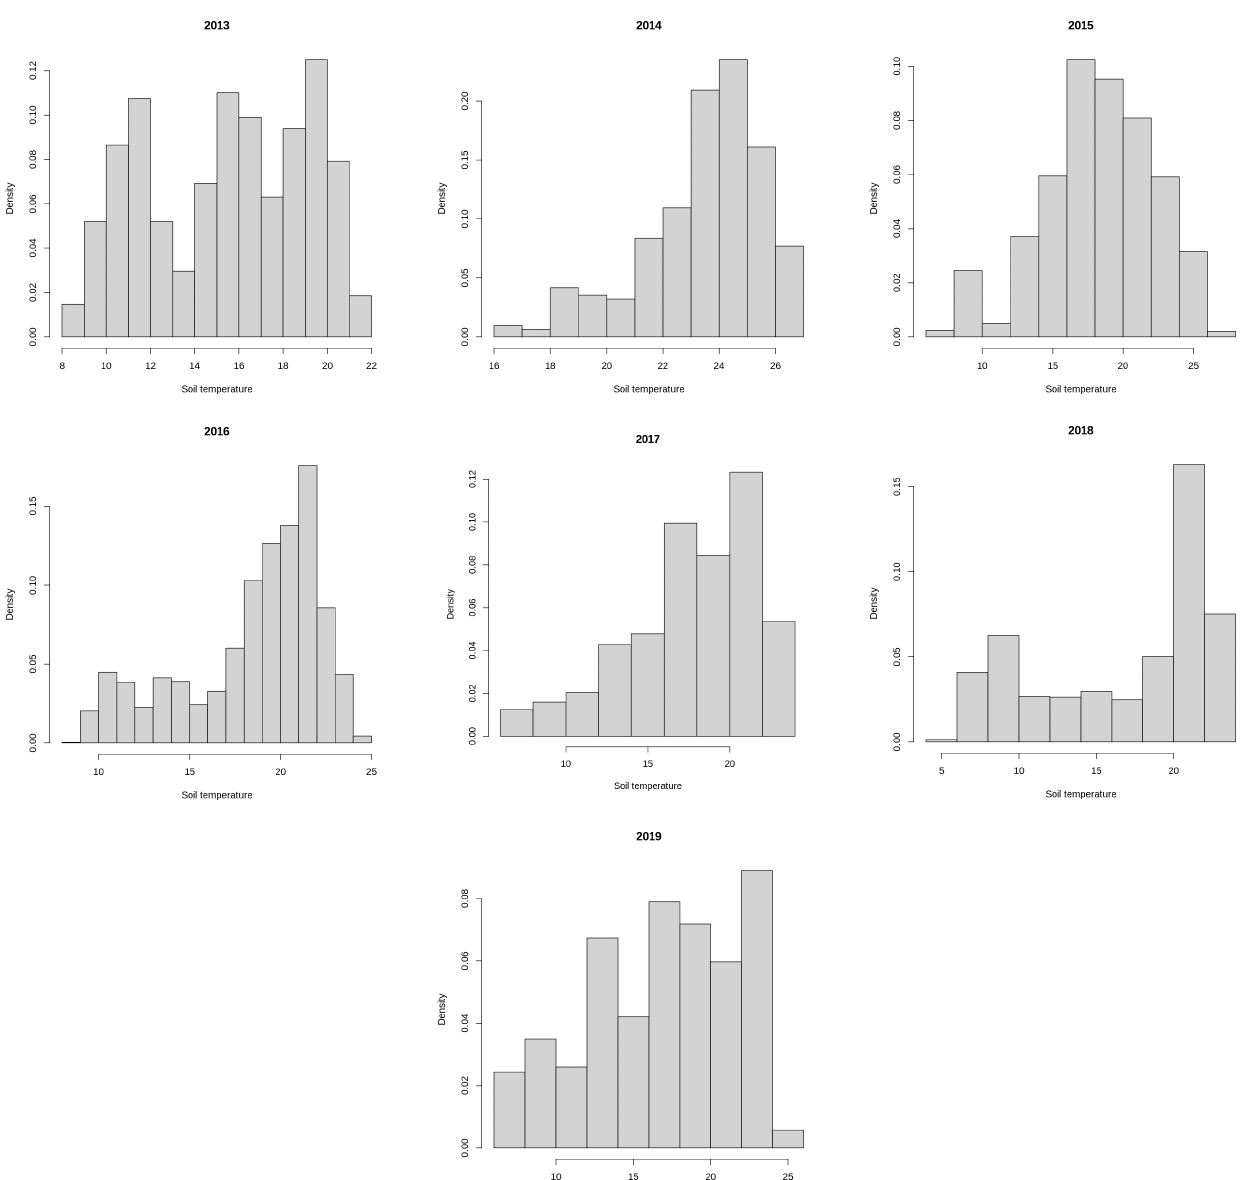
Figure A1. Distribution of soil temperature measurements at 30 cm, the arable land monolith, the lysimeter station for 2013–2019, Poluyamki, Altai Krai, Russia. Available data from August to September in 2013; June of 2014; from May to September in 2015 and 2016; from May to August in 2017, 2018 and 2019. Calculated by the authors based on hourly data from LYS.